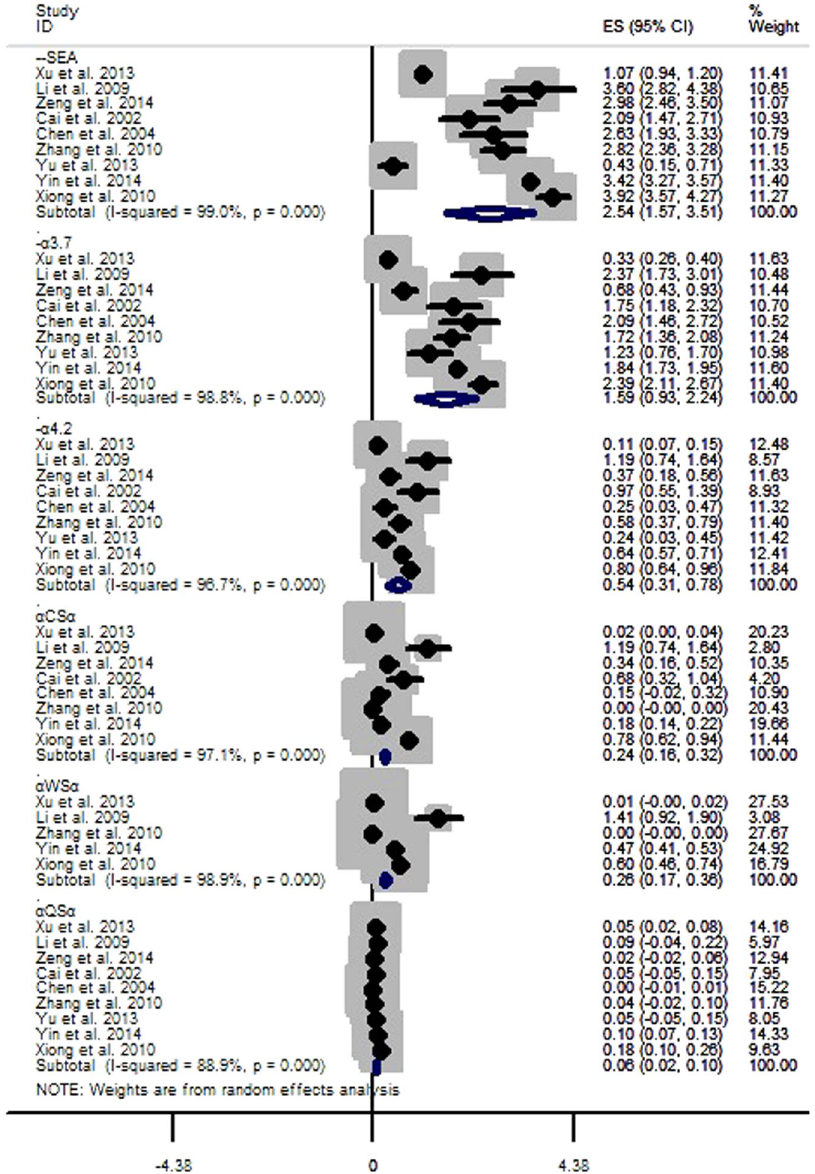
Figure 5. Gene frequencies of α -thalassemia